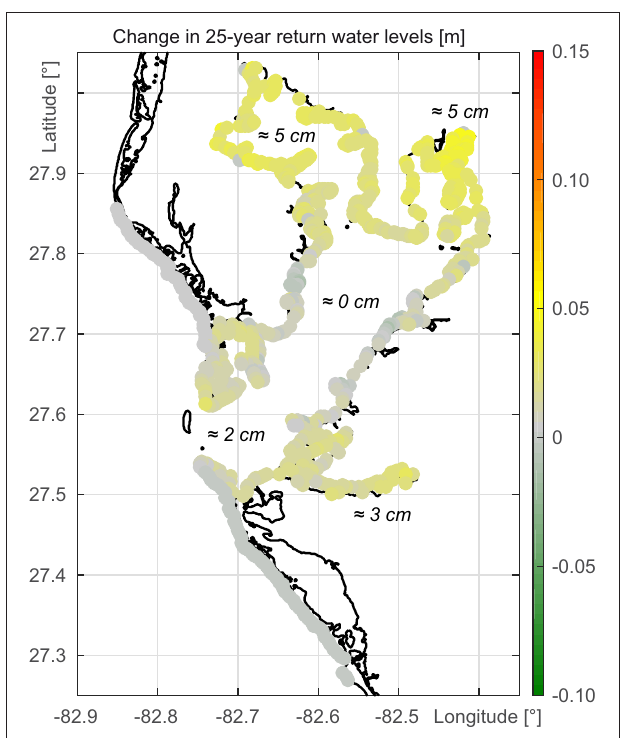
FIGURE 7 | Change in 100-year return water levels for available grid points along the Tampa Bay and Gulf coastline.